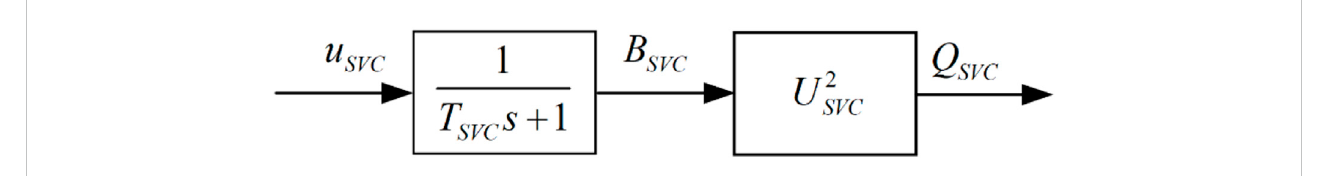
FIGURE 4 Equivalent transfer function of the control loop in the SVC.